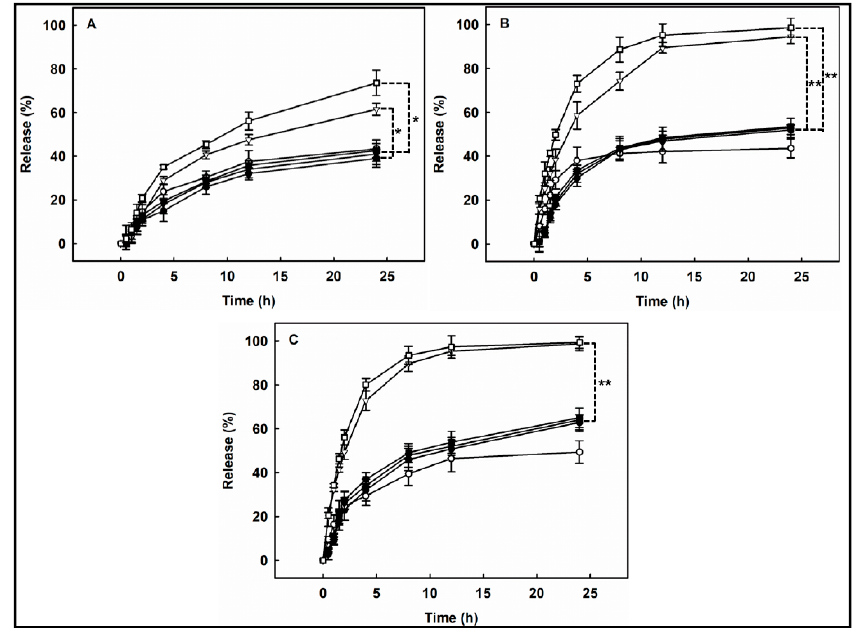
Figure 8. Release profile of Nile red loaded in P(HEA- co -ABZ) (filled symbols) and P(HEA- co -PVS)(97 / 3) micelles (empty symbols) at 25 °C ( A ), 37 °C ( B ), and 45 °C ( C ), when the H 2 O 2 concentration of release medium was 0% ( ● , ○ ), 0.5% ( ▼ , ▽ ), and 1.0% ( ■ , □ ). The data are expressed as mean ± SD ( n = 3) (* p < 0.01, ** p < 0.001 vs. the P(HEA- co -ABZ) micelle for each H 2 O 2 concentration).